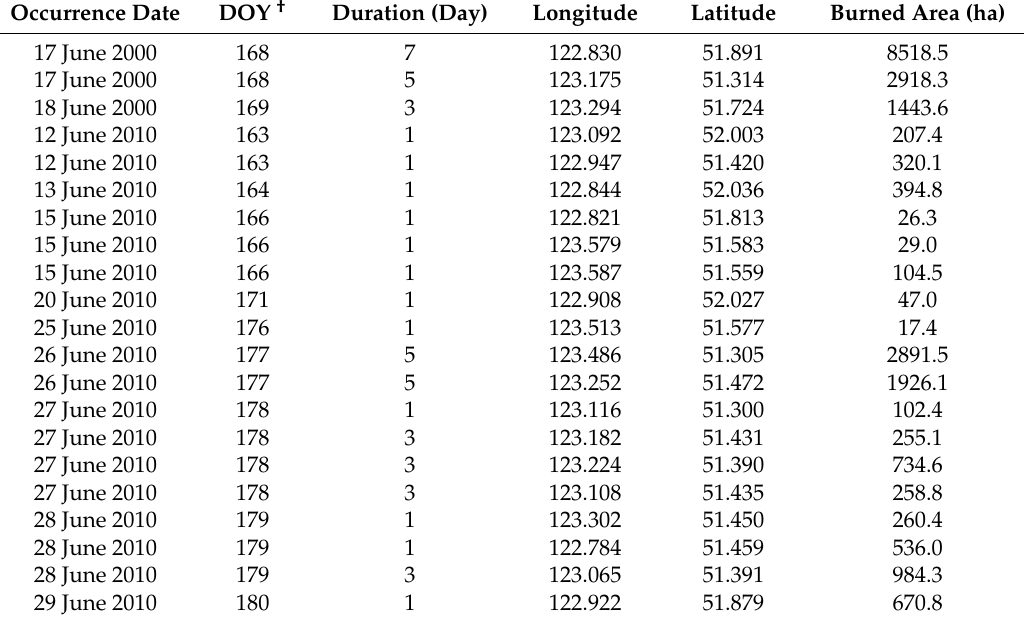
Table 1. Detailed information of 21 fires included in this